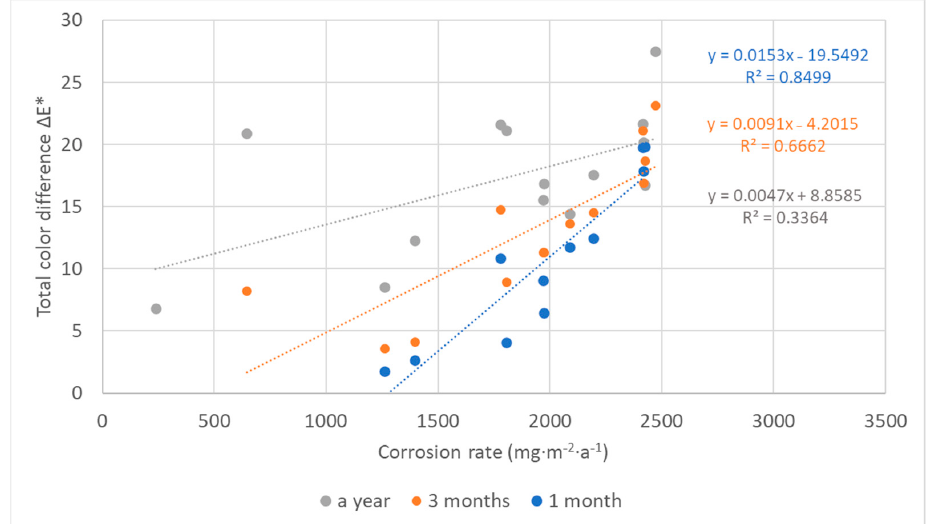
Figure 16. Comparison of corrosion rates of lead based on mass losses after one-year exposure with total color changes after 1, 3, and 12 months (locations 4, 11, 12, and 18 are excluded).